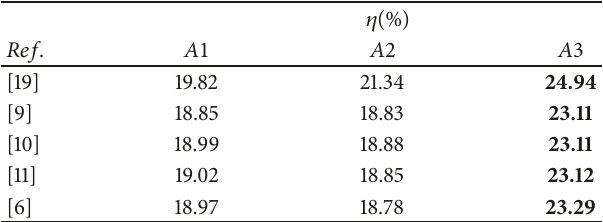
Table 8: Energy saving rates for 𝑚 = 368 : A1, A2, and A3 are the same as in Table